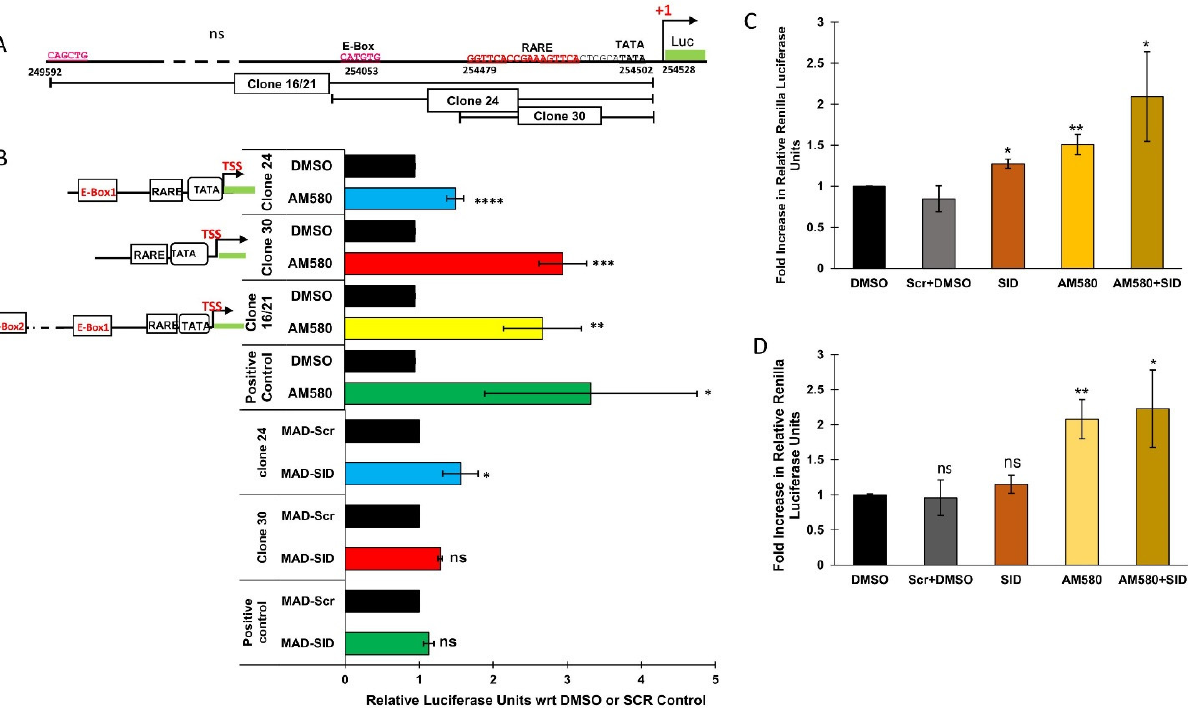
Figure 4. The RAR β promoter is controlled by both MAD1 and RAR α : the RAR β promoter was analyzed for the presence of the E-Box and Retinoic Acid Response Elements (RARE). Luci- ferase clones driven by different regions of the RAR β promoter were generated. ( A ) Arrangement